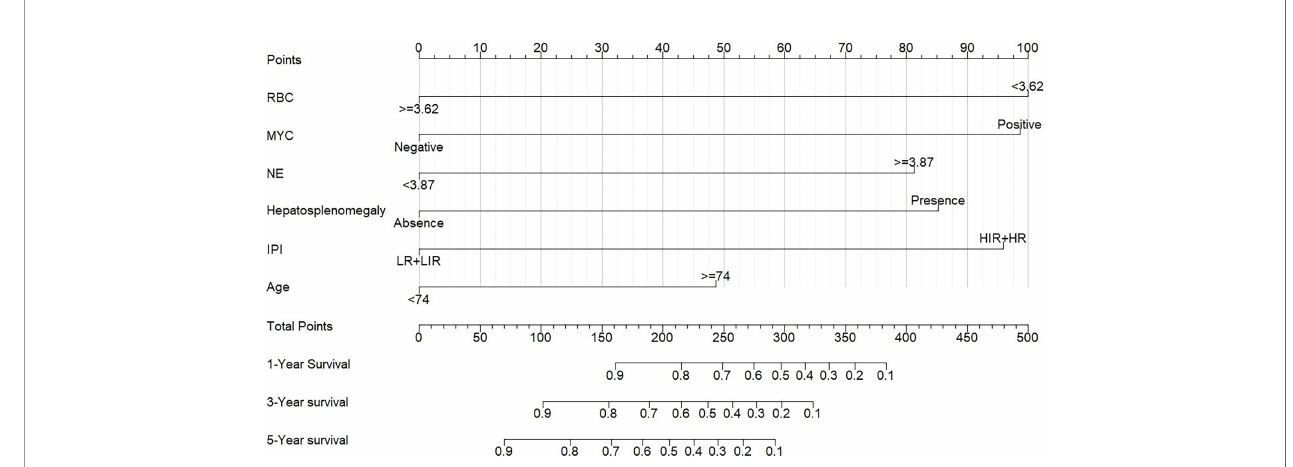
FIGURE 4 | Nomogram for patients with CD5+ DLBCL. To use the nomogram, the speci fi c points of individual patients are located on each variable axis. Black lines are drawn upward to determine the points received by each